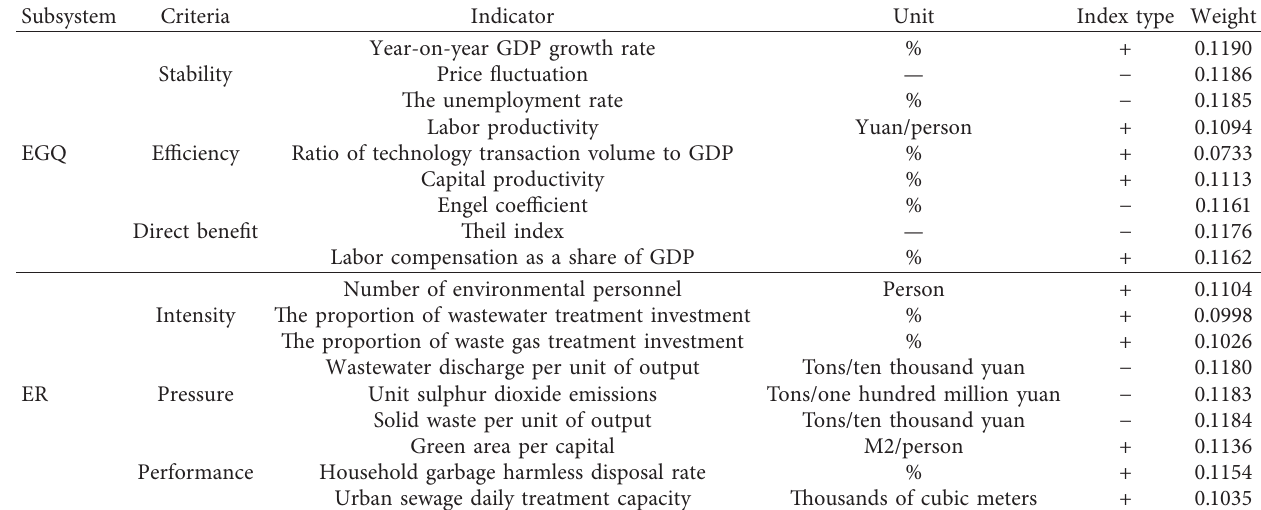
Table 1: The indicator system of the